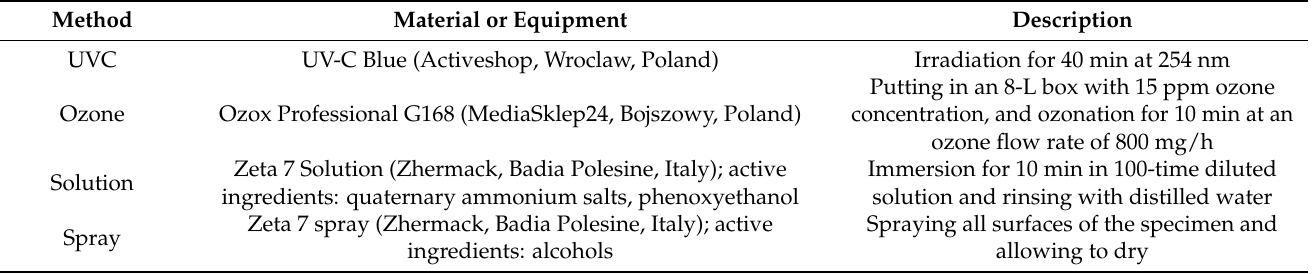
Table 5. Parameters of the disinfection methods applied in this